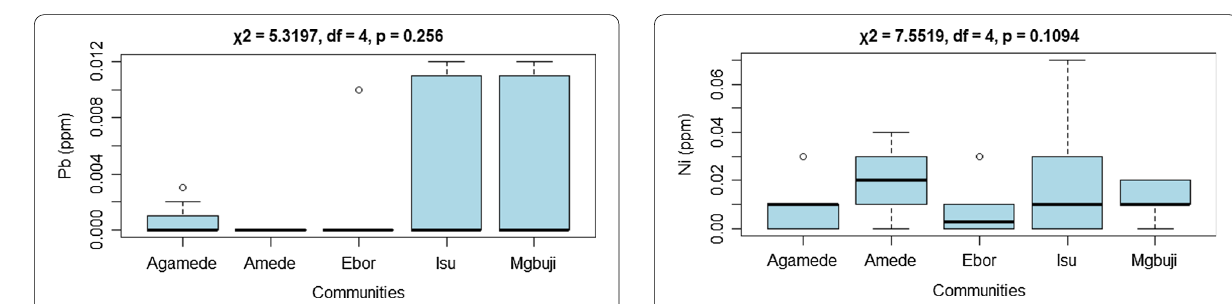
Fig. 2 Comparison of bioaccumulation of Ni in Achatina spp amongst sampled